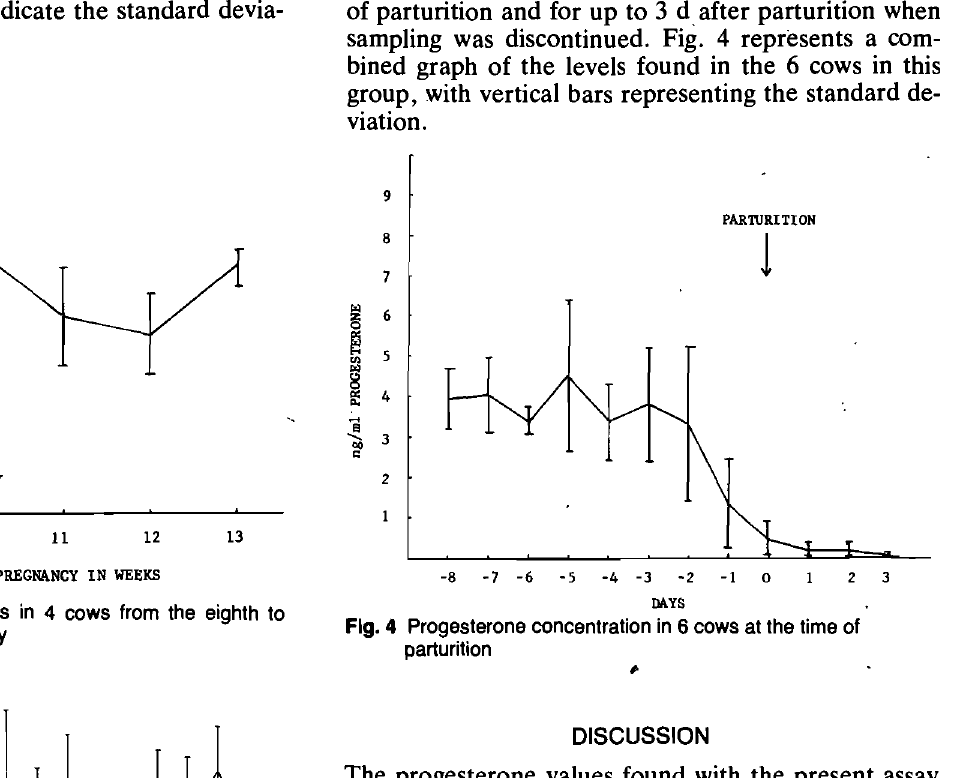
Fig. 2 Progesterone concentrations in 4 cows from the eighth to thirteenth week of pregnancy